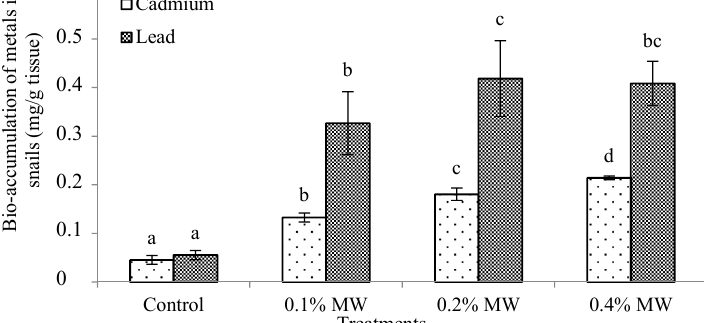
Fig. 3. Bioaccumulation of cadmium and lead in soft tissues of galba truncatula